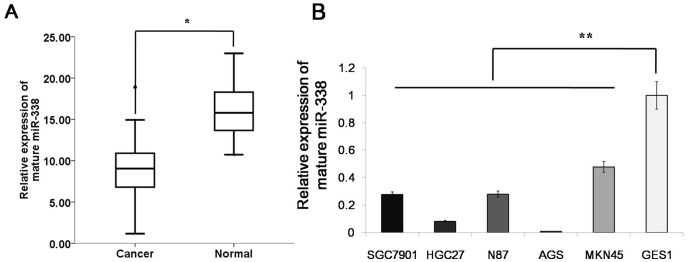
miR-338 is down-regulated in gastric cancer tissues and cell lines.(A) The expression levels of mature miR-338 in gastric cancer (n = 41) and adjacent normal mucosa tissues (n = 24) were determined using quantitative PCR. Both the gastric cancer and adjacent normal mucosa samples were fresh dissected. The expression level of mature miR-338 in the gastric cancer tissues was significantly lower than in the adjacent normal mucosa tissues. The data from the cell lines and the human samples are shown separately. * p<0.01(B)miR-338 was decreased in the gastric cancer cell lines (SGC7901, HGC27, AGS, MKN45 and N87) compared with the normal gastric mucosa cell line (GES1). The data represent the means± s.d. (n = 3) of the cell lines. ** p<0.01.